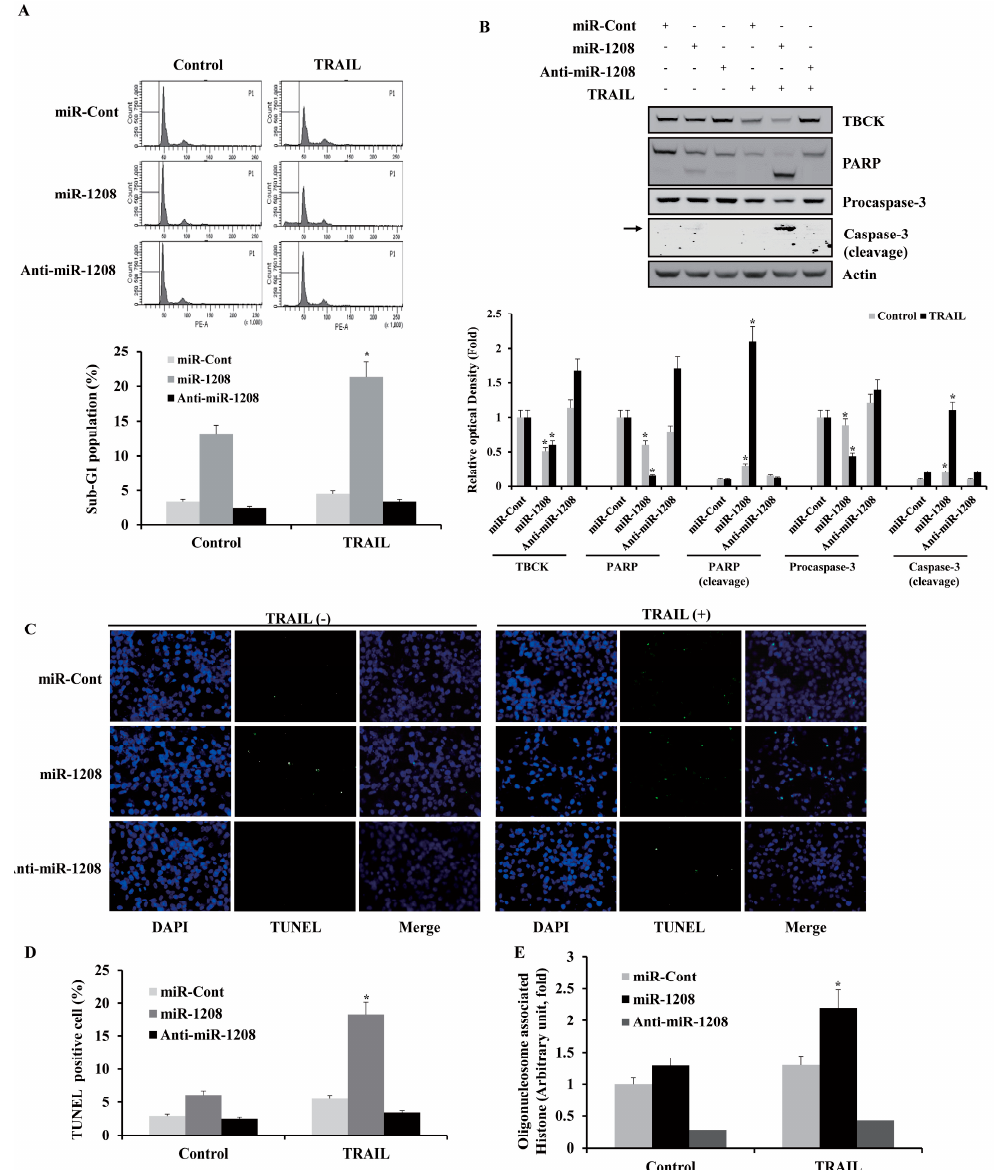
Figure 5. MiR-1208 sensitizes renal cancer cells to TRAIL-mediated apoptosis. ( A ) After Caki-1 cells were transfected with miR-1208 or miR-Cont for 24 h, cells were treated with TRAIL for 24 h. FACS analysis was performed to measure a sub-G1 fraction. Histograms of flow cytometry are shown in the upper panel . Percentages of sub G1 populations are shown in bottom panel . Data are reported as the mean ± SD ( n = 3). * indicates P < 0.05 compared to miR-Cont-transfected cells. ( B ) Equal amounts of cell lysates (50 µ g) were loaded to electrophoresis and were immunoblotted for PARP and caspase-3 antibodies. Actin was used for normalization in all immunoblots. Using ImageJ software, the intensity of each protein in miRNA and TRAIL-treated cells were normalized to actin and expressed as a ratio of the densitometric value ( bottom panel ). * indicates P < 0.05 compared to miR-Cont-transfected cells. ( C ) After Caki-1 / miR-1208 and Caki-1 / miR-Cont cells were treated with TRAIL, TUNEL analysis was performed. TUNEL-stained cells were observed by fluorescence microscopy at × 200 magnification. TUNEL-positive cells are shown in green. * indicates P < 0.05 compared to miR-Cont-transfected cells. See high-resolution images in Supplementary Figure S2. ( D ) The graphs show numbers of TUNEL-positive cells. * indicates P < 0.05 compared to miR-Cont-transfected cells. ( E ) Nuclei and fragmented DNA were detected by using a DNA fragmentation detection kit. * indicates P < 0.05 compared to miR-Cont-transfected cells.